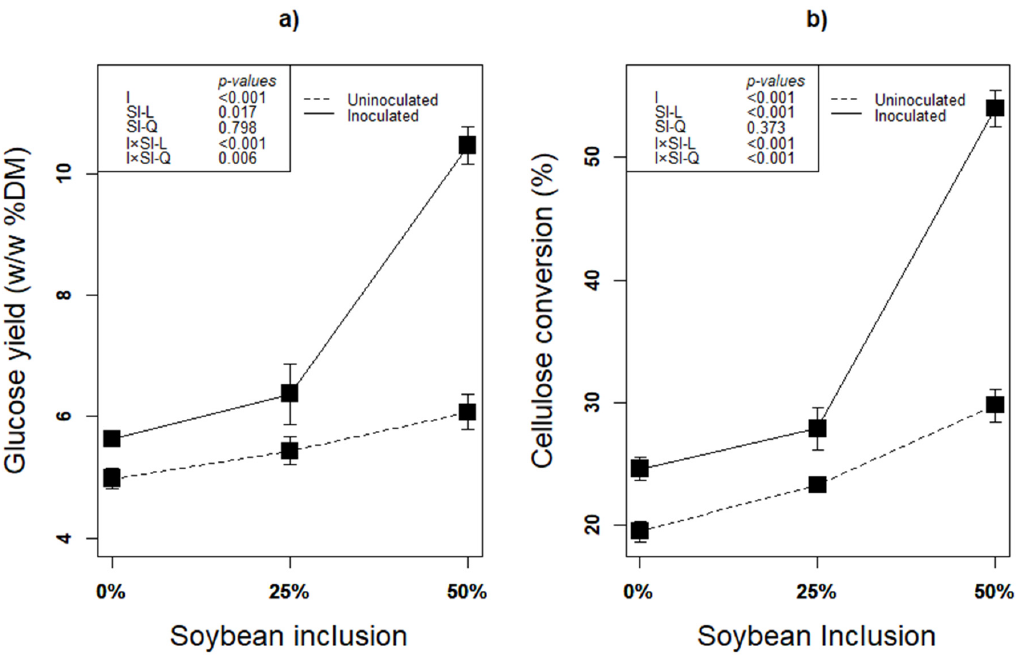
Figure 5. ( a , b ): Influence of soybean inclusion and L. plantarum A1 inoculation on glucose yield and cellulose conversion of sorghum silage. cellulose conversion of sorghum